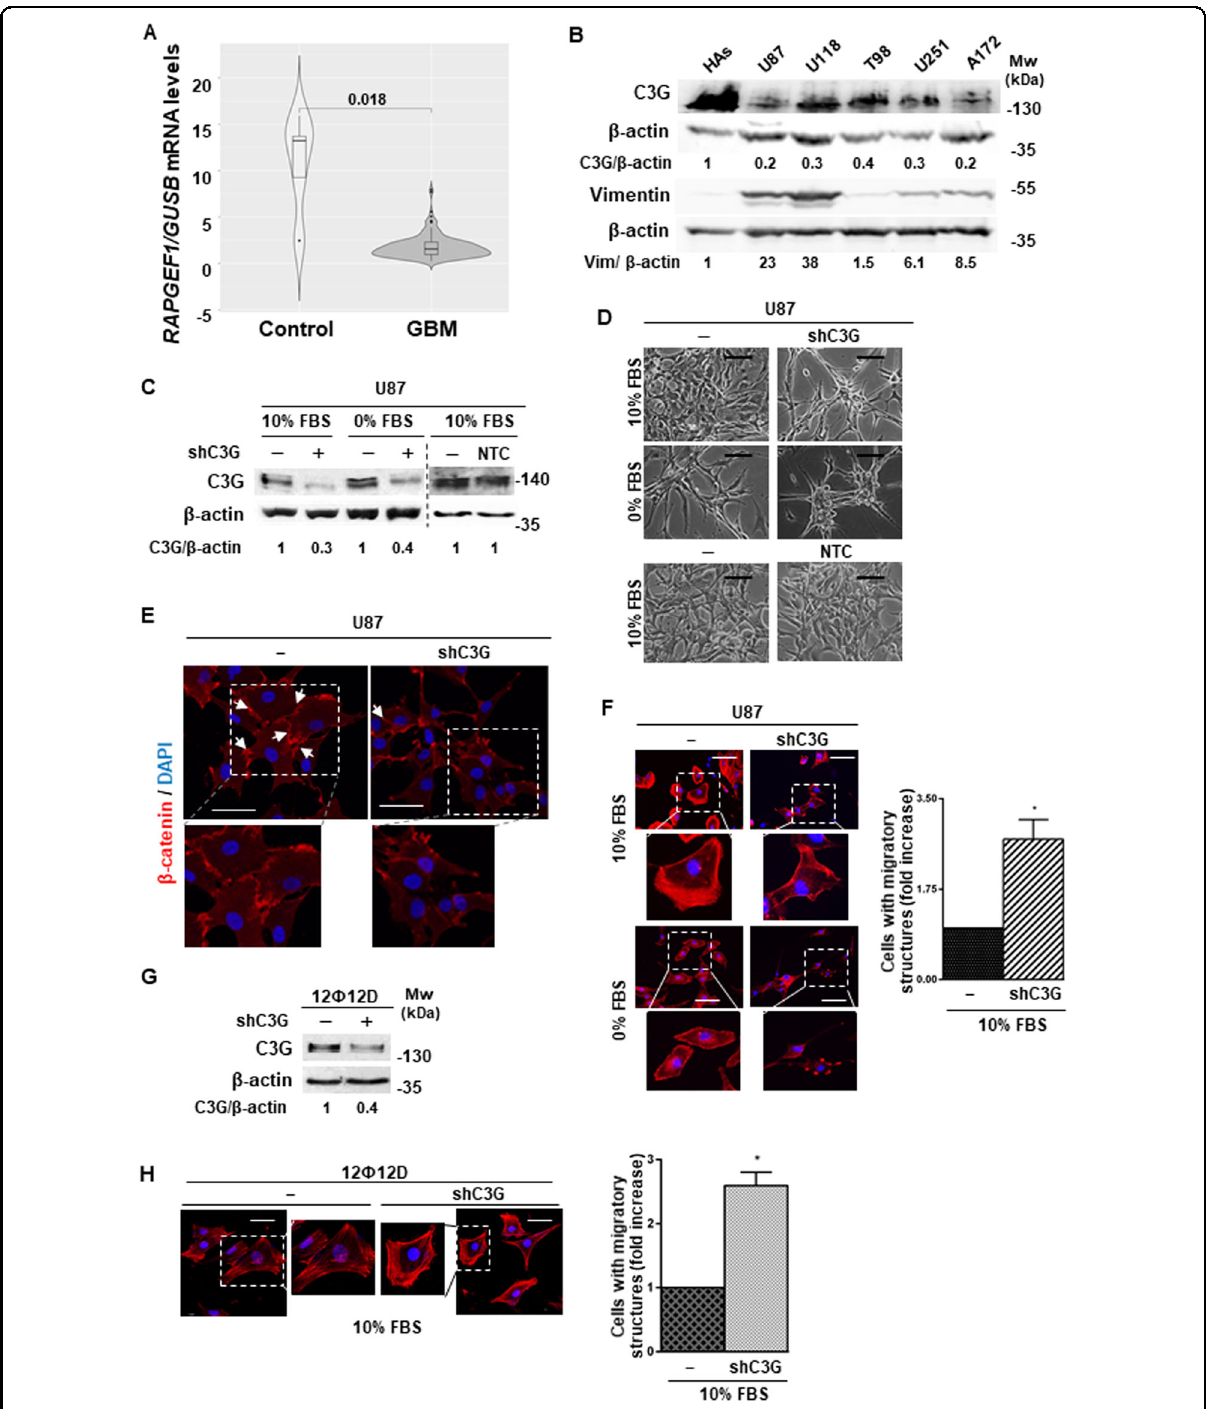
Fig. 1 C3G is downregulated in GBM promoting changes in cell morphology. A C3G ( RAPGEF1 ) mRNA levels in GBM patients and normal brain (171 patients) obtained from TCGA database normalized with GUSB . B Western-blot analysis of C3G and Vimentin protein levels in the indicated GBM cell lines and human astrocytes (HAs) normalized to β -actin. Densitometric quanti fi cation of C3G/ β -actin and Vimentin/ β -actin ratios are shown. C , G Western-blot analysis of C3G normalized to β -actin to con fi rm silencing in U87 and 12 Ф 12D cells as compared to parental cells and/or cells with control shRNA (NTC). Densitometric quanti fi cation of C3G/ β -actin ratio is shown. D Phase-contrast microscopy images of parental U87, U87shC3G and NTC cells maintained either in the presence (10% FBS) or absence (0% FBS) of serum for 24h. Scale bars: 50µm. E Representative images of β -catenin (red) and DAPI (blue) staining analyzed by confocal microscopy. Scale bars: 25µm. F and H Left panels,immuno- fl uorescencemicroscopy imagesofphalloidinstaining(red)inparentalandC3G-silencedU87and12 Ф 12Dcells,maintainedasindicated. Cell nuclei were stained with DAPI (blue). Scale bars: 50µm. An ampli fi cation of cells inside the square is also shown. Right panels, histograms showing the quanti fi cation of the number of cells presenting migratory structures ( fi lopodia, blebs, stress fi bers and/or lamellipodia) expressed as fold increase. Of fi cial journal of the Cell Death Differentiation